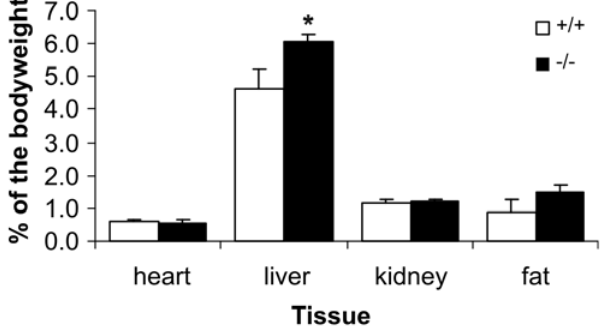
Figure 3. Effects of fasting on organ weights in wild-type and Decr 2 / 2 mice. Age-matched male mice were fasted for 24 h, after which they were sacrificed. The wet weight of selected organs (heart, liver, kidney and fat) was determined and compared between wild type and Decr 2 / 2 mice. Weights were calculated as a percentage of body weight and are expressed as means 6 SE of 4–6 mice of each genotype per group. Asterisks (*) denote significant differences (p , 0.01) between wild type and Decr 2 / 2